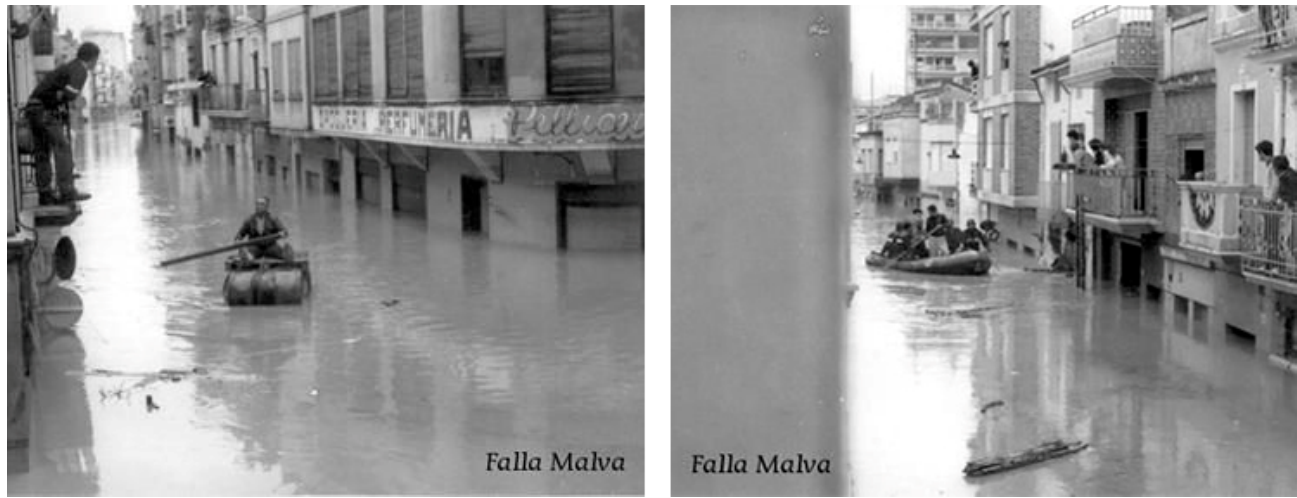
Figure 1. Alzira. Flood of 20 October 1982. Source: http://www.fallamalva.com (accessed on 30 May 2020).